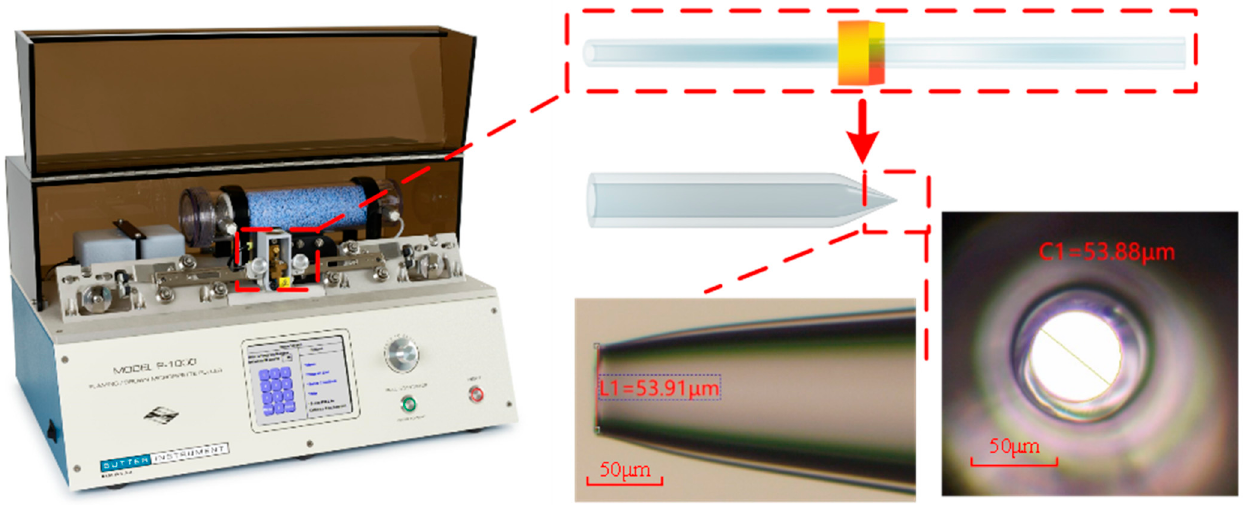
Table 1. Micropipette puller setup parameters.